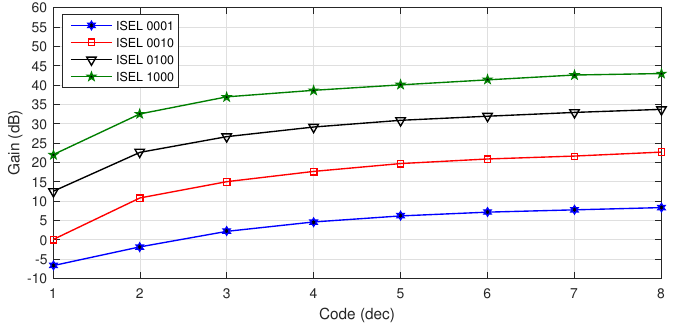
Figure 16. Measured VR AFE gain range for different gain